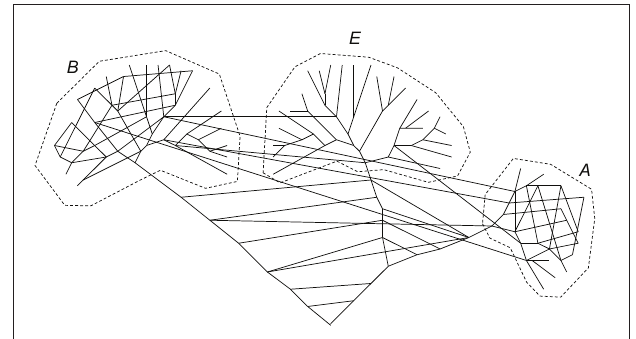
FIGURE 2 | A network representation of the evolutionary process. The network still includes some tree components such that the three domains of cellular life remains distinct but there is also an extensive horizontal component of genetic information flow that in particular dominates the earliest stages of evolution (Koonin and Wolf,